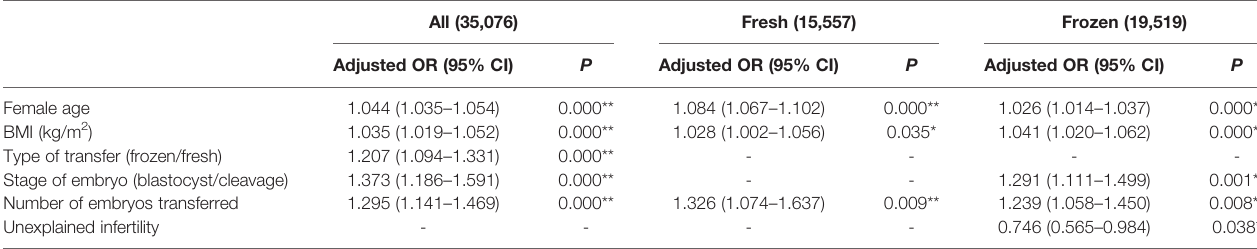
TABLE 2 | Factors associated with ESA rate using logistic regression